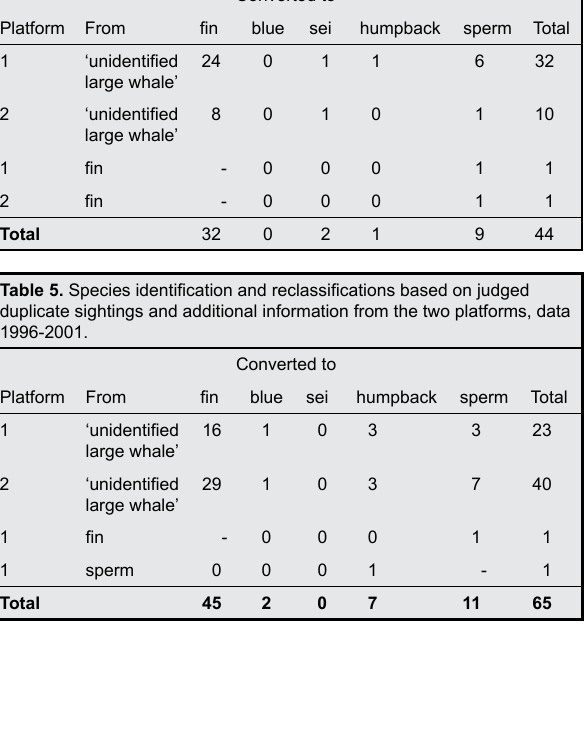
Table 4. Species identification and reclassification based on judged dupli - cate sightings from the two platforms, 1995 survey. Converted to Platform From